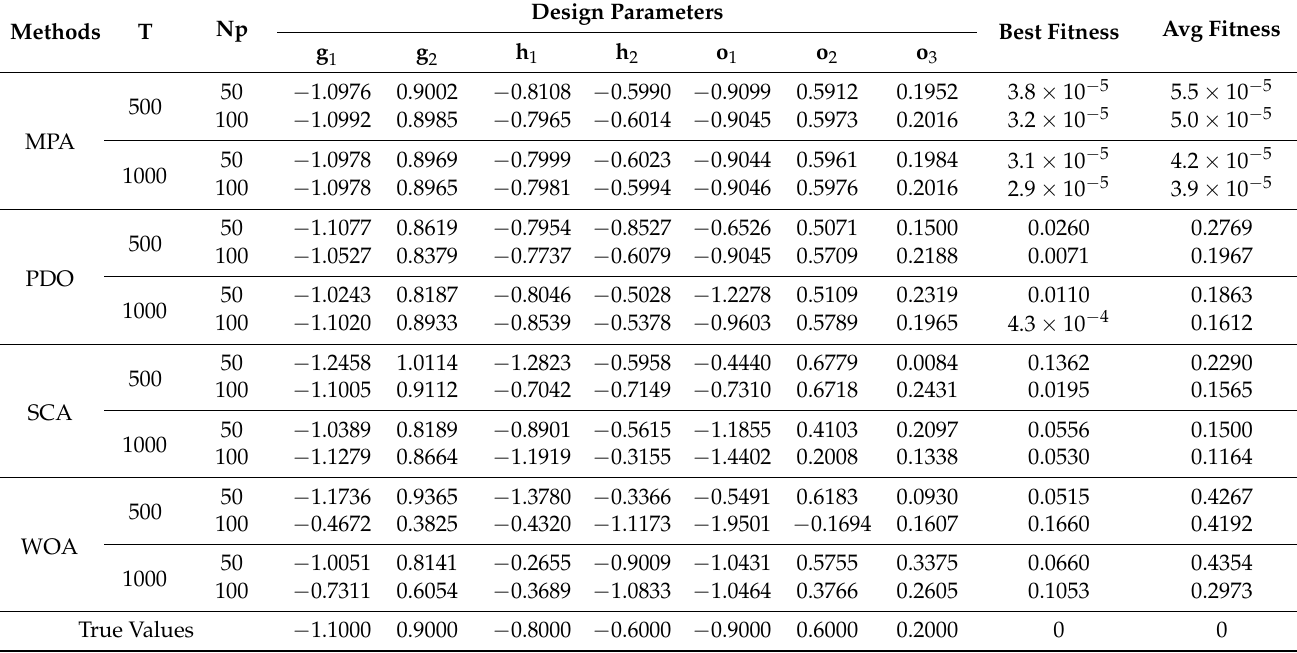
Table 4. Estimated weight analysis w.r.t generation and population sizes at 40 dB noise for case study 1.